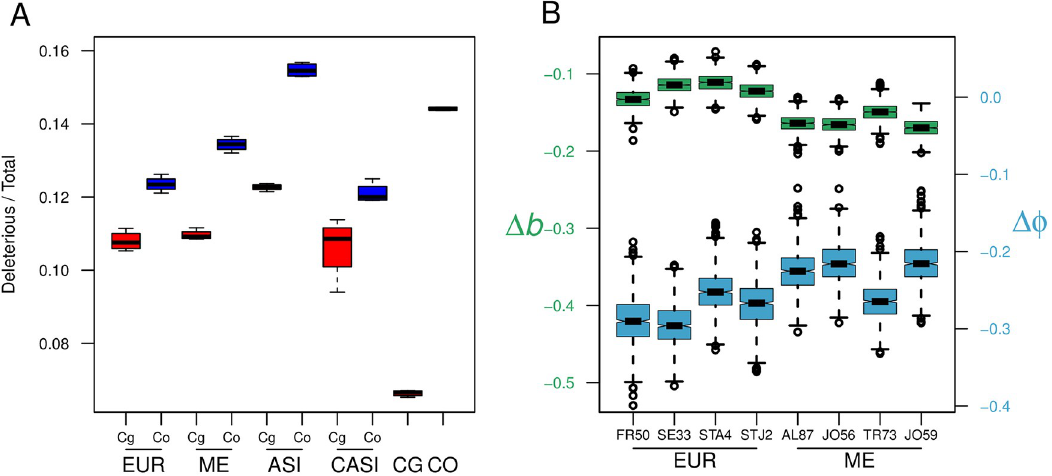
Fig 8. Variation in deleterious mutations in the two subgenomes of C. bursa-pastoris . A . Proportion of deleterious mutations in the subgenomes and in the parental species. CO, CG, ASI, EUR, ME, CASI correspond to C. orientalis , C. grandiflora , and four populations of C. bursa-pastoris , respectively. The two subgenomes are indicated with Co and Cg. Functional effects were annotated with the C. rubella SIFT database (the annotation with A. thaliana SIFT database is in the S10 Fig). B . Maximum likelihood estimates of parameters of the distribution of deleterious mutations on Cbp Cg genes. Each box represents the estimates for one accession, with 1000 bootstrap replicates. The estimates are presented as the difference between the estimated parameter for deleterious mutations, DEL , and the estimated parameter for synonymous mutations, SYN ( Δ b = bDEL − bSYN , Δ φ = φDEL − φSYN ). Notches represent the median and the 95% confidence interval. The left axis refers to Δ b (green boxes), and the right axis refers to Δ φ (blue boxes). The estimated parameters ( b and φ ) for DEL and SYN are shown separately in S11